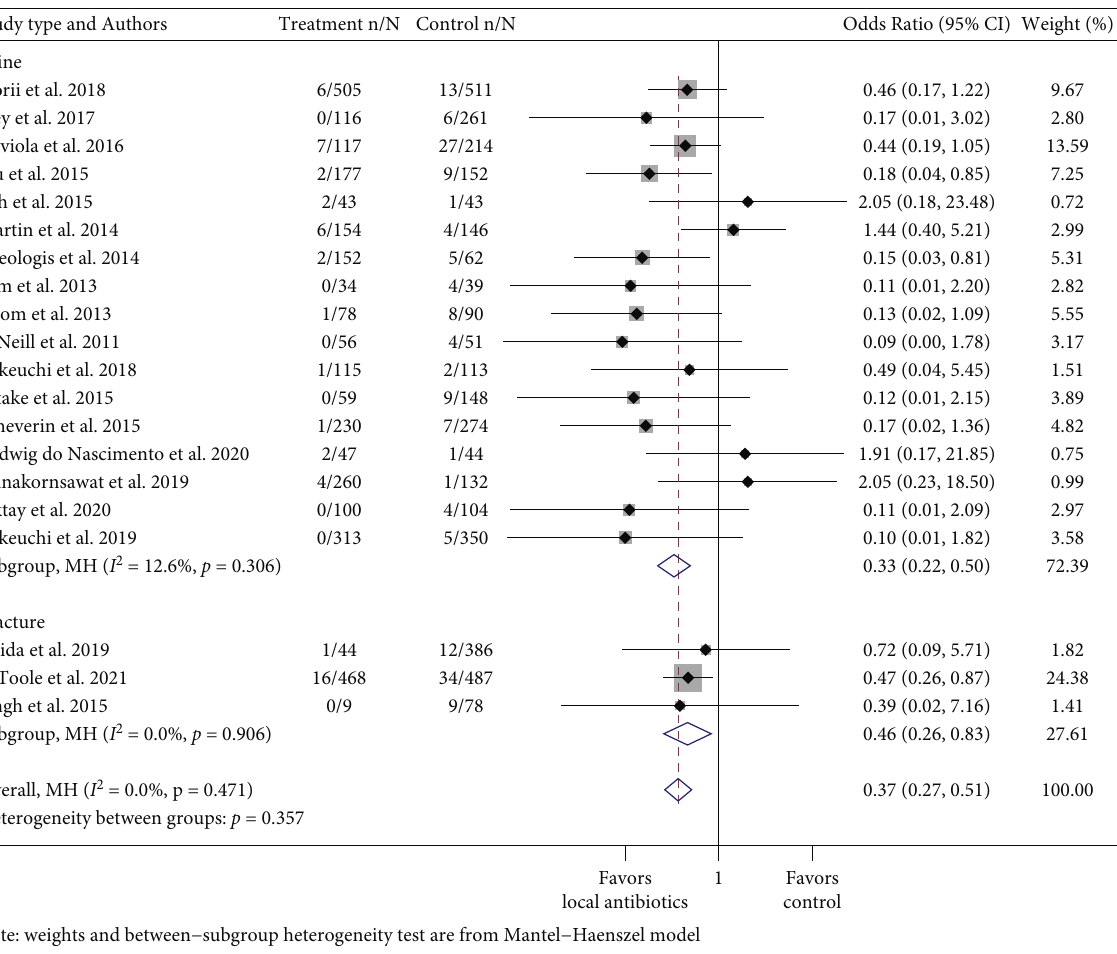
Figure 6: Forest plot of Gram-positive infection data of studies that used vancomycin with subgroup analysis for spine and fracture cases. Treatment n/N: number of infections in the treatment group/total number of patients in the treatment group. Control n/N: number of infections in the control group/total number of patients in the control